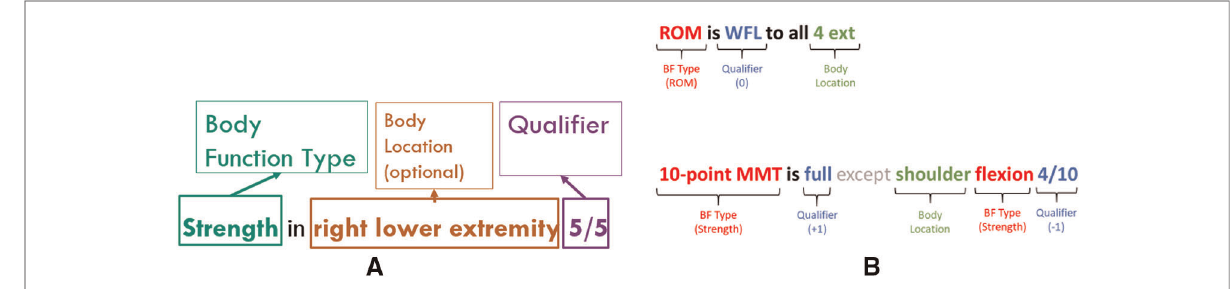
FIGURE 3 ( A ) Fully formed body function mentions. ( B ) Examples of body function mentions in the clinical text.